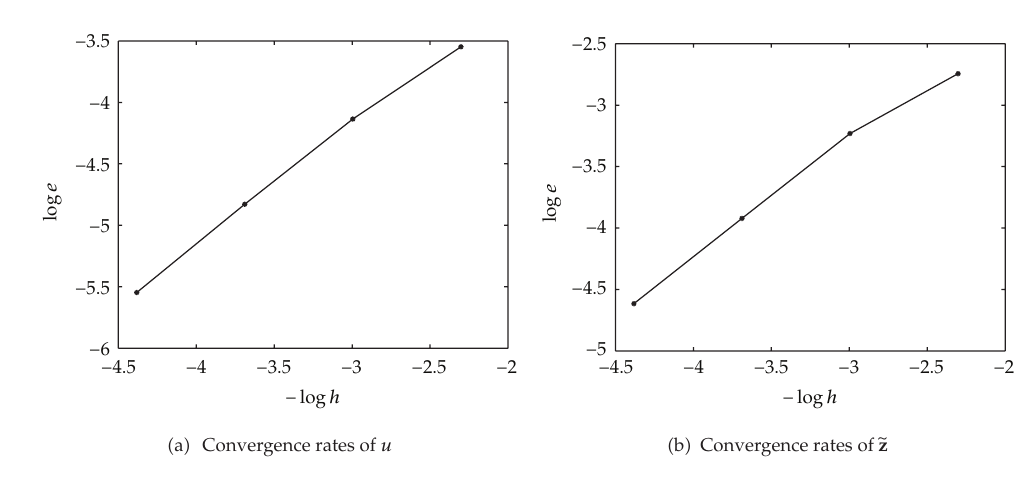
Figure 1: Convergence rate figures.